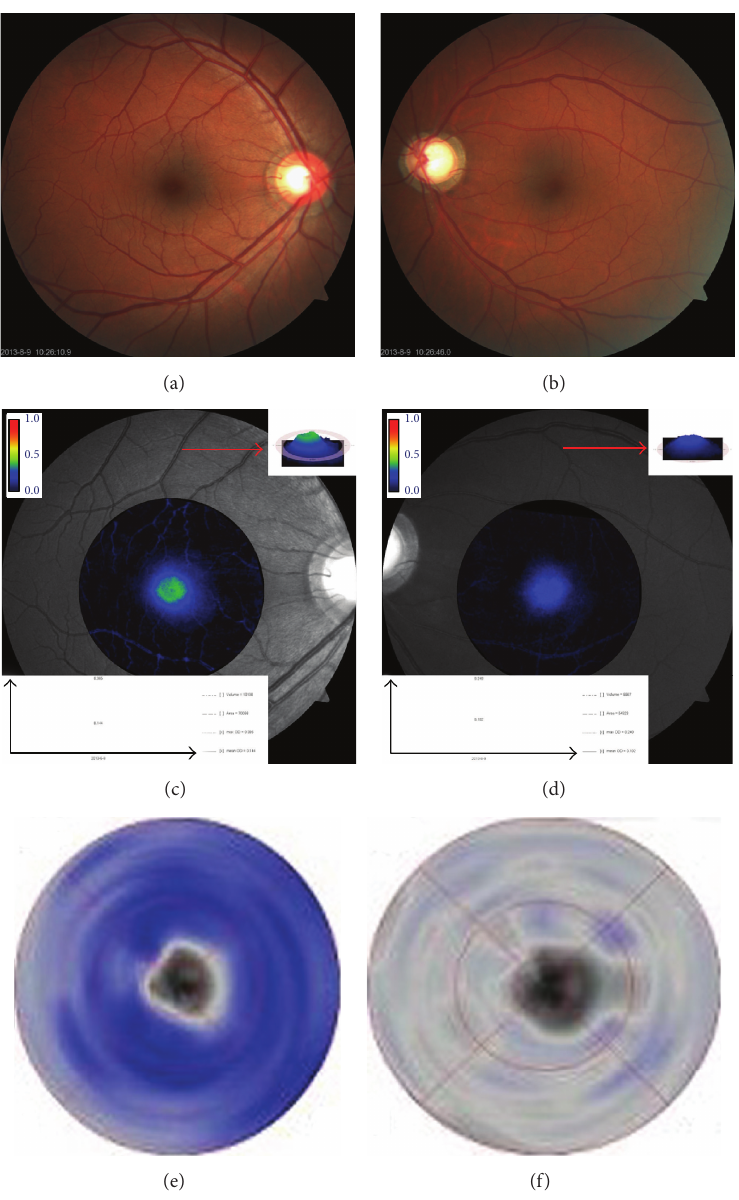
Figure 2: Patient examples of MPOD and GCC. (a) Fundus photography of case 1 with a cup to disc ratio of approximately 0.6. (b) Fundus photography of case 2 with a cup to disc ratio of approximately 0.9. (c and d) MPOD profile indicating that case 1 (c) exhibits a higher MPOD than case 2 (d) (red arrow). (e and f) GCC profile indicating that case 1 (e) exhibits a thicker GCC than case 2 (f) (deeper blue means thicker